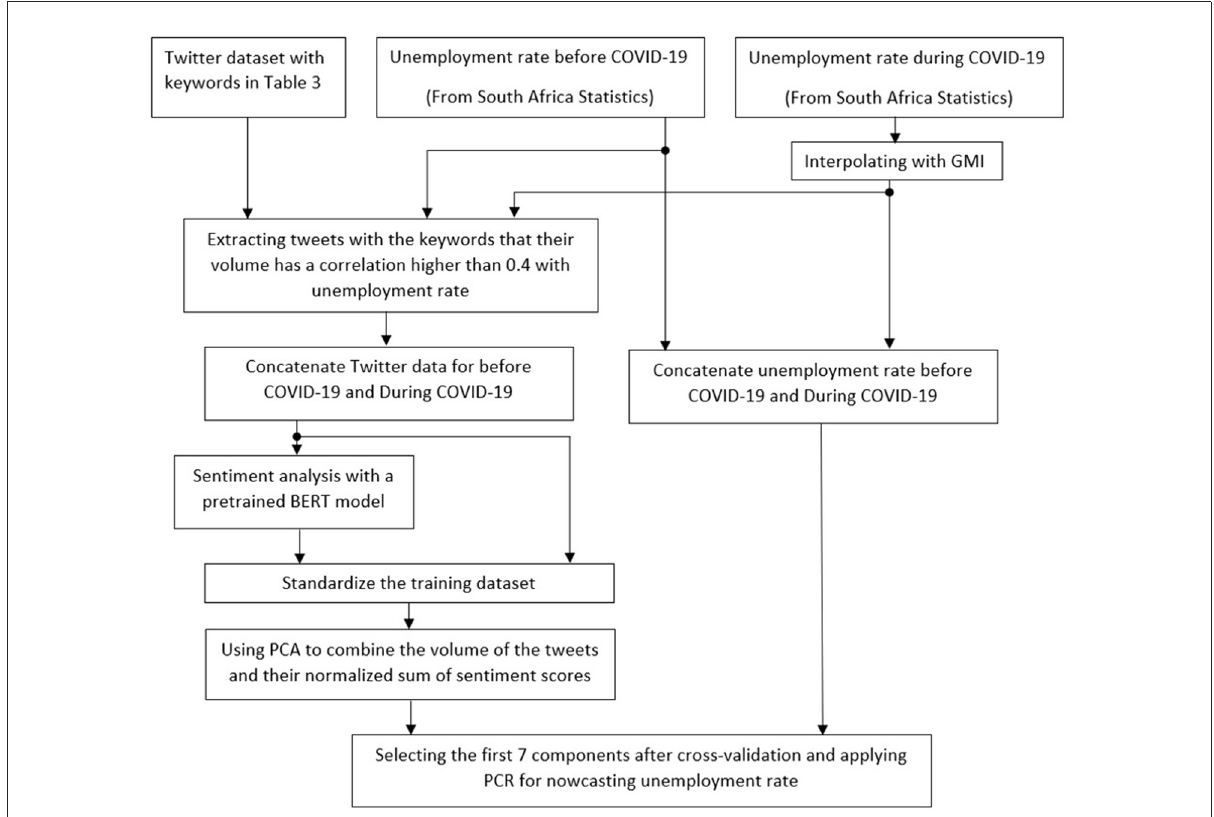
FIGURE1 The overall architecture of the